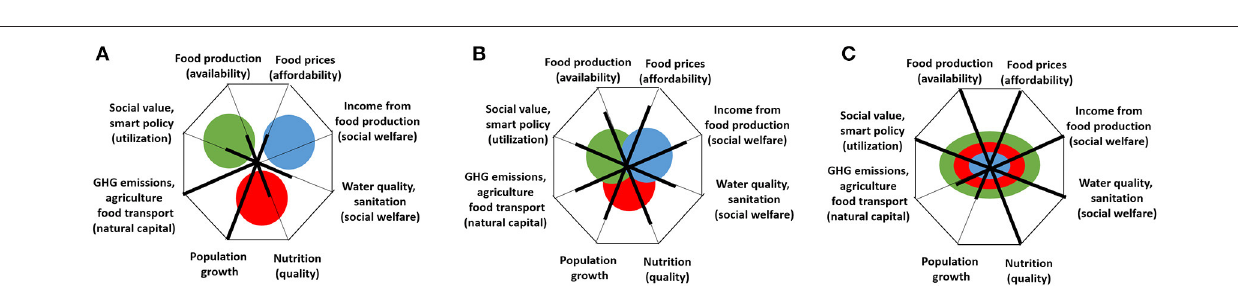
FIGURE 4 | Trade-offs among example environmental outcomes (GHG emissions), social welfare outcomes (income), food security outcomes and population growth for a given food system that have (A) no cross-scale interactions occurring between driver variables from broader to finer scales and levels with minimal multidimensional effects; (B) driver variables interactions across scales and levels; (C) cross-scale interaction due to feedbacks between driver and response variables. This figure is adapted from Ericksen